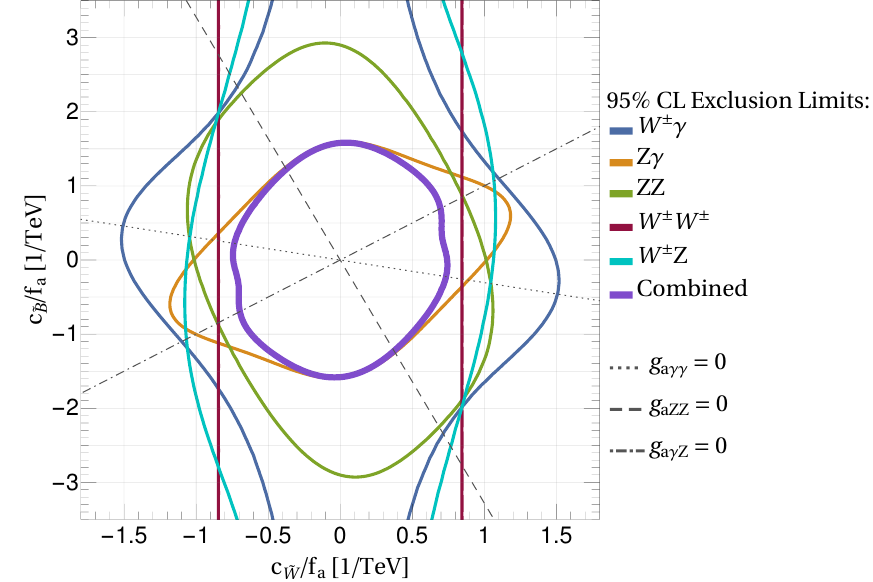
Figure 3 . Observed 95% CL exclusion limits in the ( c Run 2 CMS publications and signal events with M V individually for the five different experimental channels considered and for their combination. The thin dotted, dashed and dot-dashed lines indicate the directions of vanishing couplings to neutral gauge